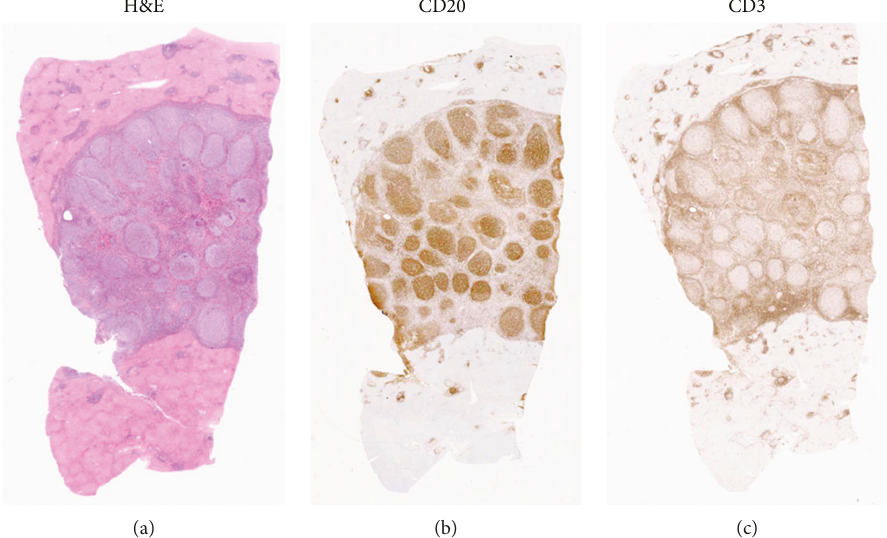
Figure 3: Hematoxylin-eosin stain of a section through the center of the nodule (a) shows numerous con fl uent lymphoid follicles composed of large, reactive lymphocytes with intervening smaller lymphoid cells. An immunostain for the B cell marker CD20 (b) shows that the follicles are composed of B cells, while the stain for the T cell marker CD3 (c) shows that the mantle zone and interfollicular areas have predominantly T cells, typical of benign lymphoid